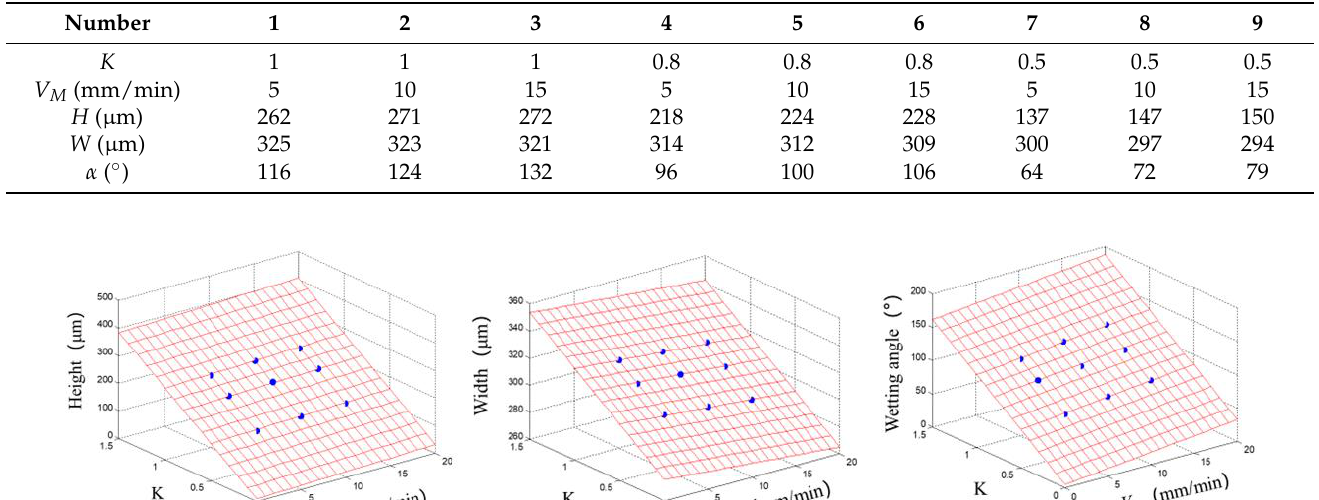
Table 7. Single-track process parameters: H , W and α .